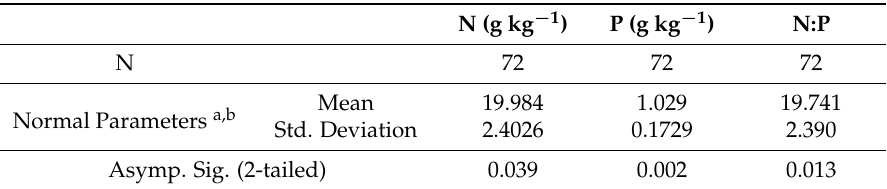
Table A1. One-Sample Kolmogorov-Smirnov